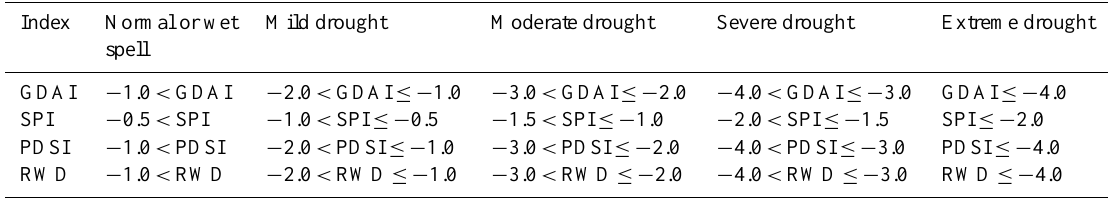
Table 6. Classification of the GDAI, SPI, PDSI, and RWD.